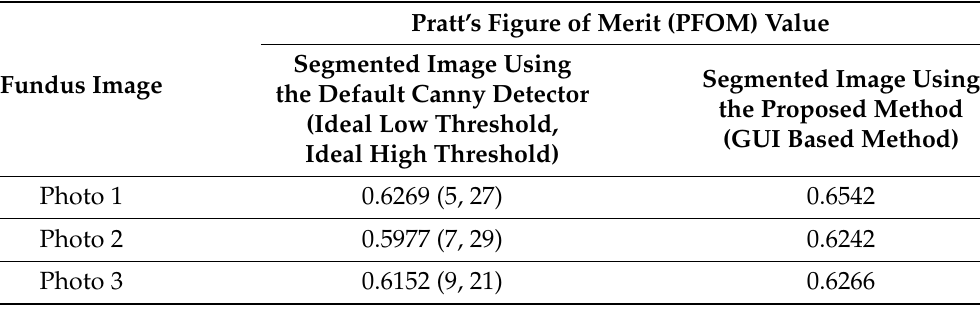
Table 3. Comparison of PFOM for segmented